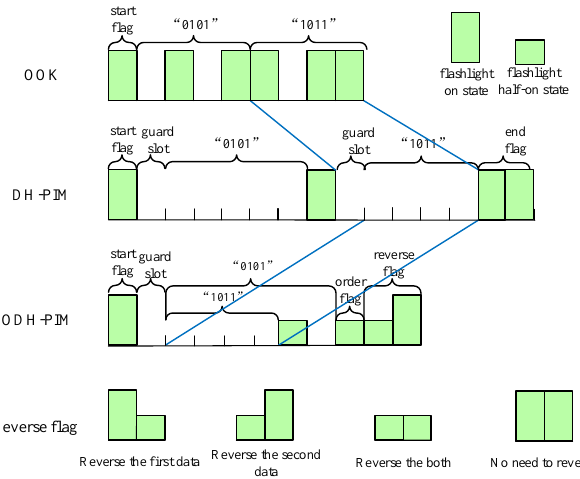
Figure 4. Three modulation comparison. Bit series “01011011”.